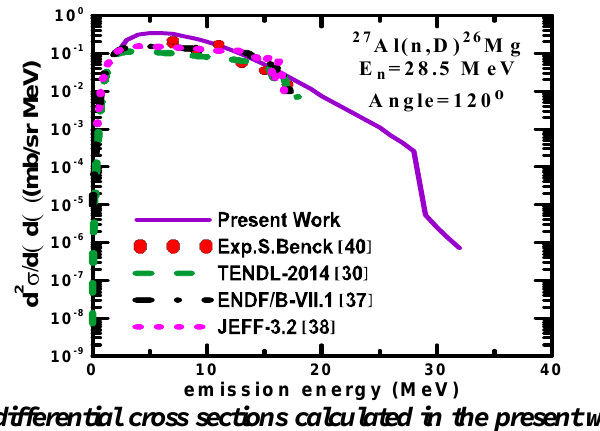
Fig. 8: The double differential cross sections calculated in the present work as a function of emission energy and different emission angle 120 0 for the reaction 27 Al+n and emitted deuterium at 28.5 MeV compared with experimental data [40] other theoretical results (TENDL [30], ENDF/B-VI [37] and JEFF-3.2